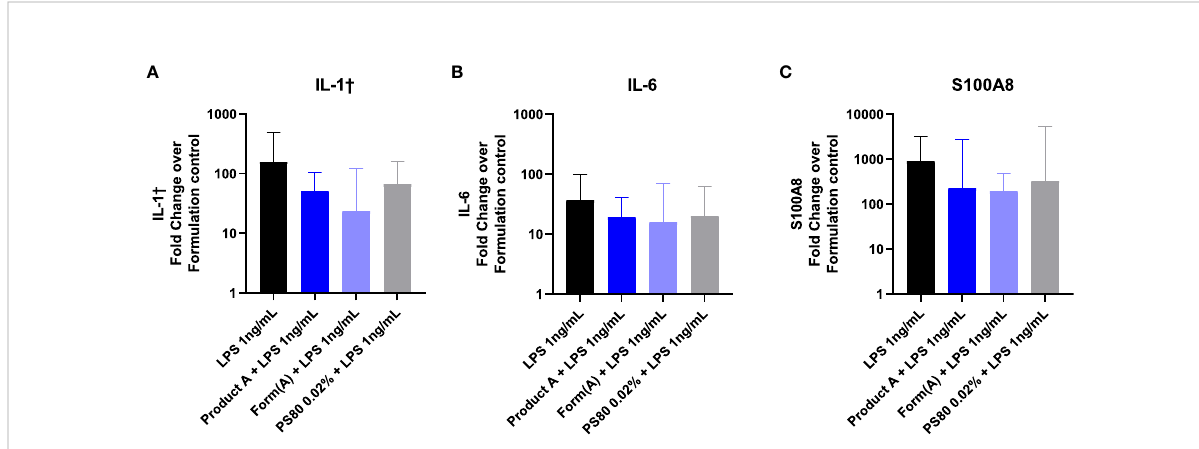
FIGURE 7 Product A does not mask detection of LPS in vivo . Mice were injected subcutaneously with 1ng of LPS with saline, product A, the formulation A, or polysorbate 80. The induction of IL-1 b (A) , IL-6 (B) , and S100A8 (C) at the site of injection was measured in skin 6 hours post injection. Results are shown as the fold increase over saline alone. Data is presented as the geometric mean and geometric SD. n =